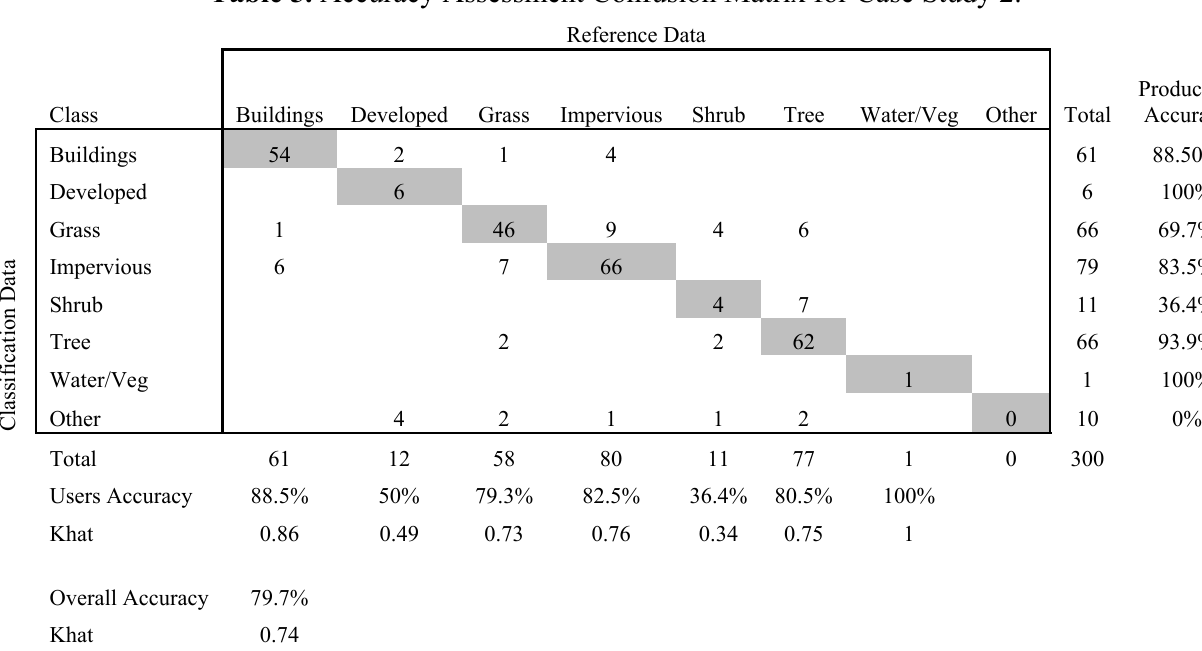
Table 5. Accuracy Assessment Confusion Matrix for Case Study 2.